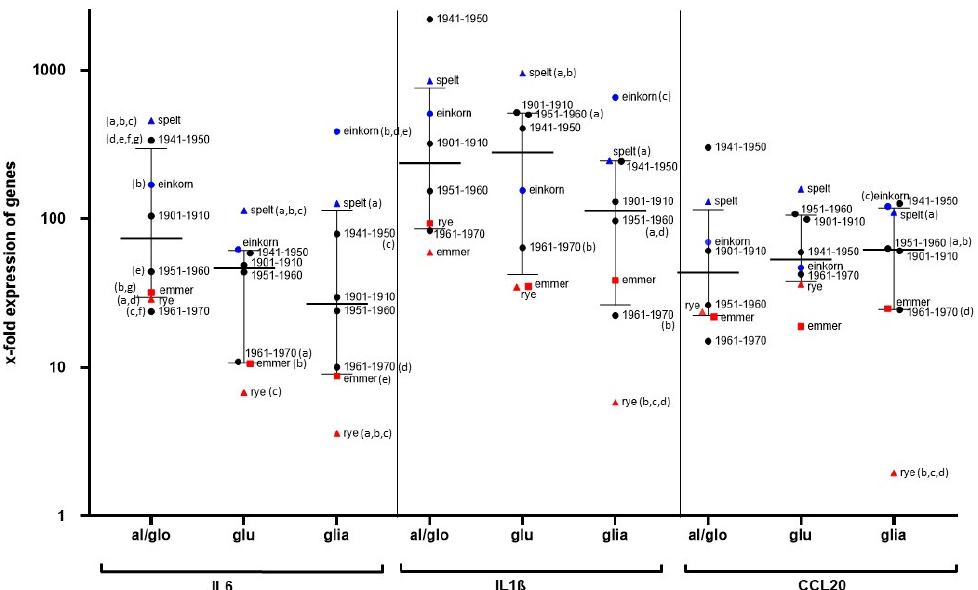
Figure 6. X-fold gene expression of IL6, IL1ß, and CCL20 in the PBMCs of healthy controls ( n = 7) after stimulation with cereal proteins. Fold-change gene expression was analyzed with the 2 − ∆∆ Ct method, using GAPDH as a housekeeping gene, and was related to values for the culture medium without cereal stimulants as a baseline. Results are shown as medians with interquartile range. The Kruskal–Wallis test with Dunn’s multiple comparisons test was used to analyze differences in gene expression after stimulation of the PBMCs of healthy controls with various cereal fractions. (a,b,c,d) means significant differences between the fractions marked with same letters.